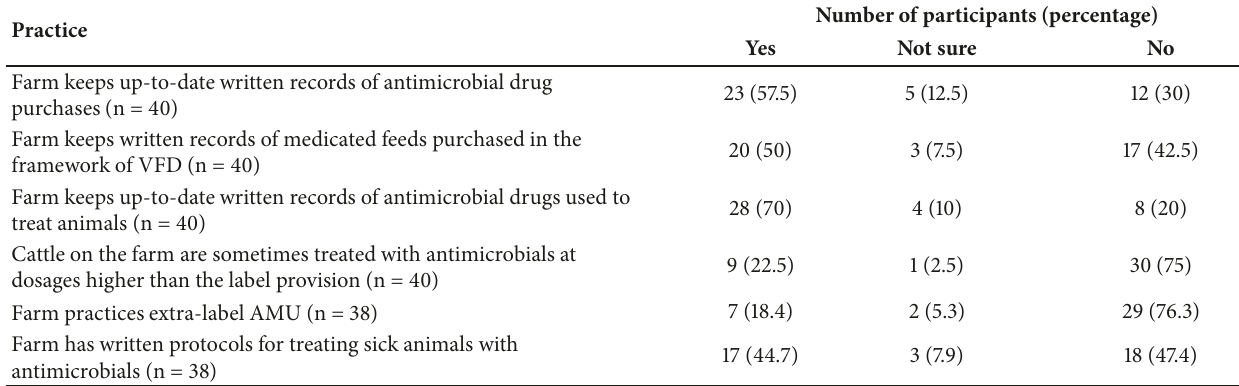
Used bacterial cultures to determine cause of disease on their farms (n = 44) Used C/S in selection of antimicrobials (n =